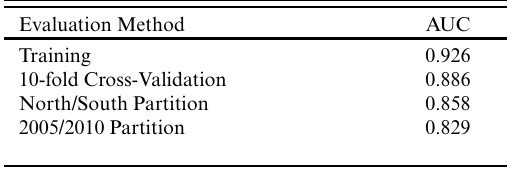
Table 5 . AUC of final model over different evaluation methods. Values are the mean over 10 model iterations.